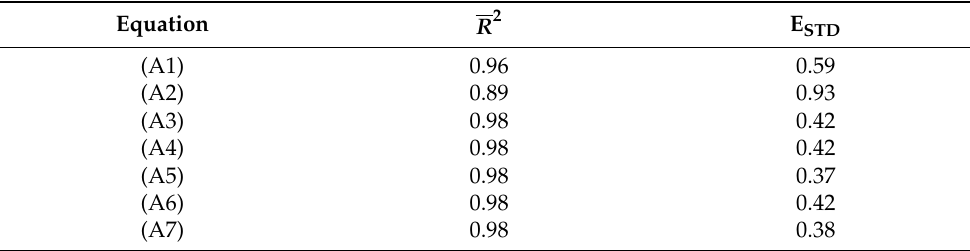
Table A1. Statistical parameters associated to the equations tested. Adjusted coefficient of determina- tion R 2 , the standard error E STD , and the number of the equation associated to each regression.